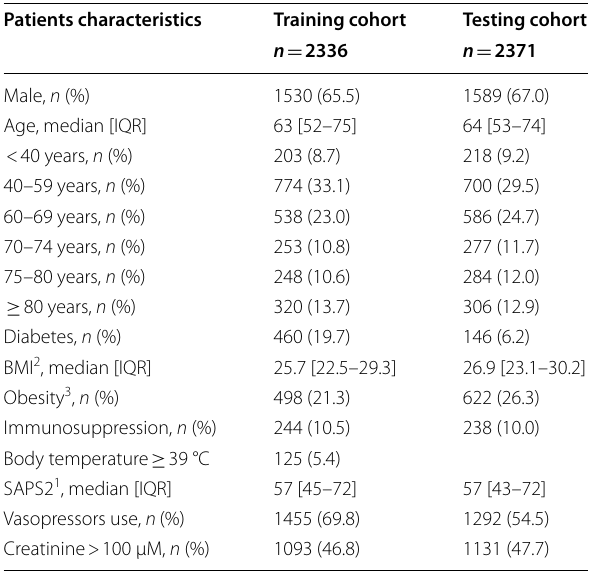
Table 1 Baseline characteristics of patients in the training and testing